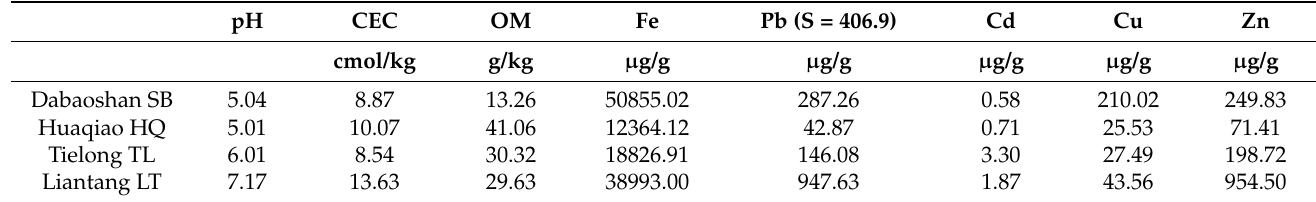
Table 1. Basic physical and chemical properties of the soil